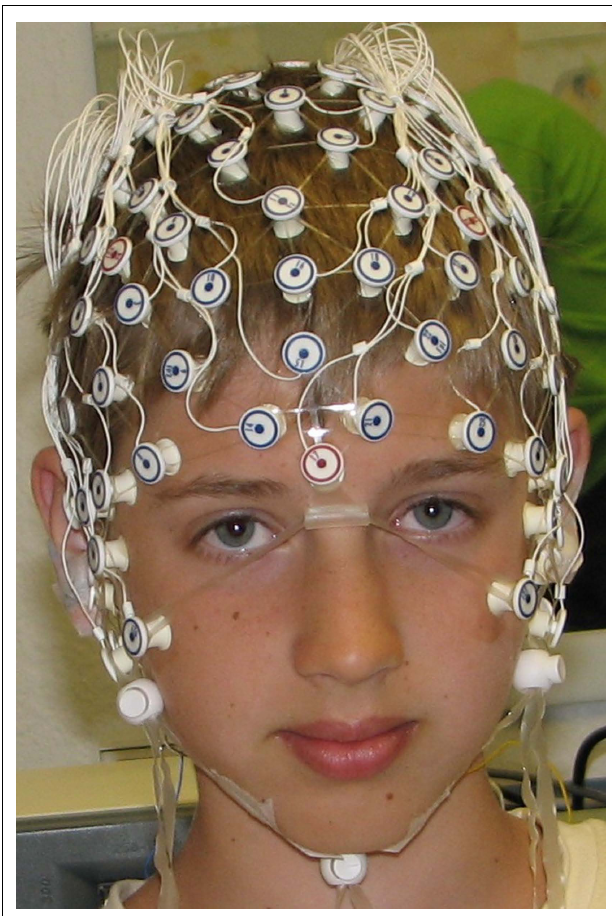
FIGURE 1 |The photo shows an 11-year-old subject wearing a high density EEG net with 128 electrodes (“dense net array” of Electrical Geodesics Inc.)